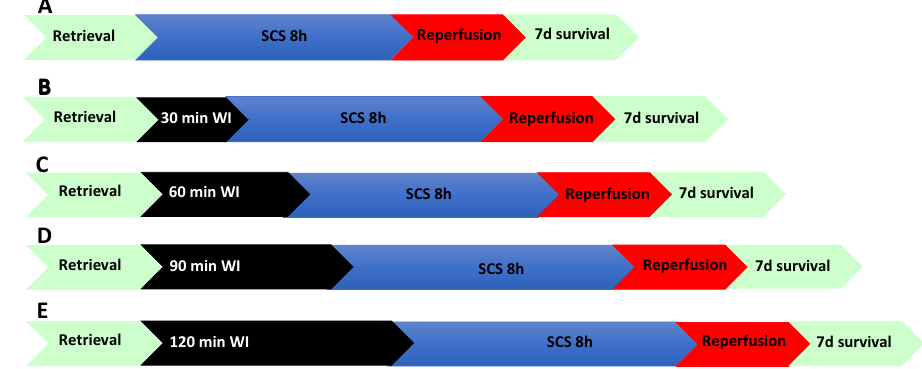
Figure 1. Experimental groups and design. Prior to procurement, animals were subjected to ( A ) 0 min (heart beating donors, n = 3), ( B ) 30 min (n = 5), ( C ) 60 min (n = 3), ( D ) 90 min (n = 3), or ( E ) 120 min (n = 6) of warm ischemia to mimic donation-after cardiac death. Animals were observed for 7 days after transplantation. SCS Static Cold Storage; WI Warm